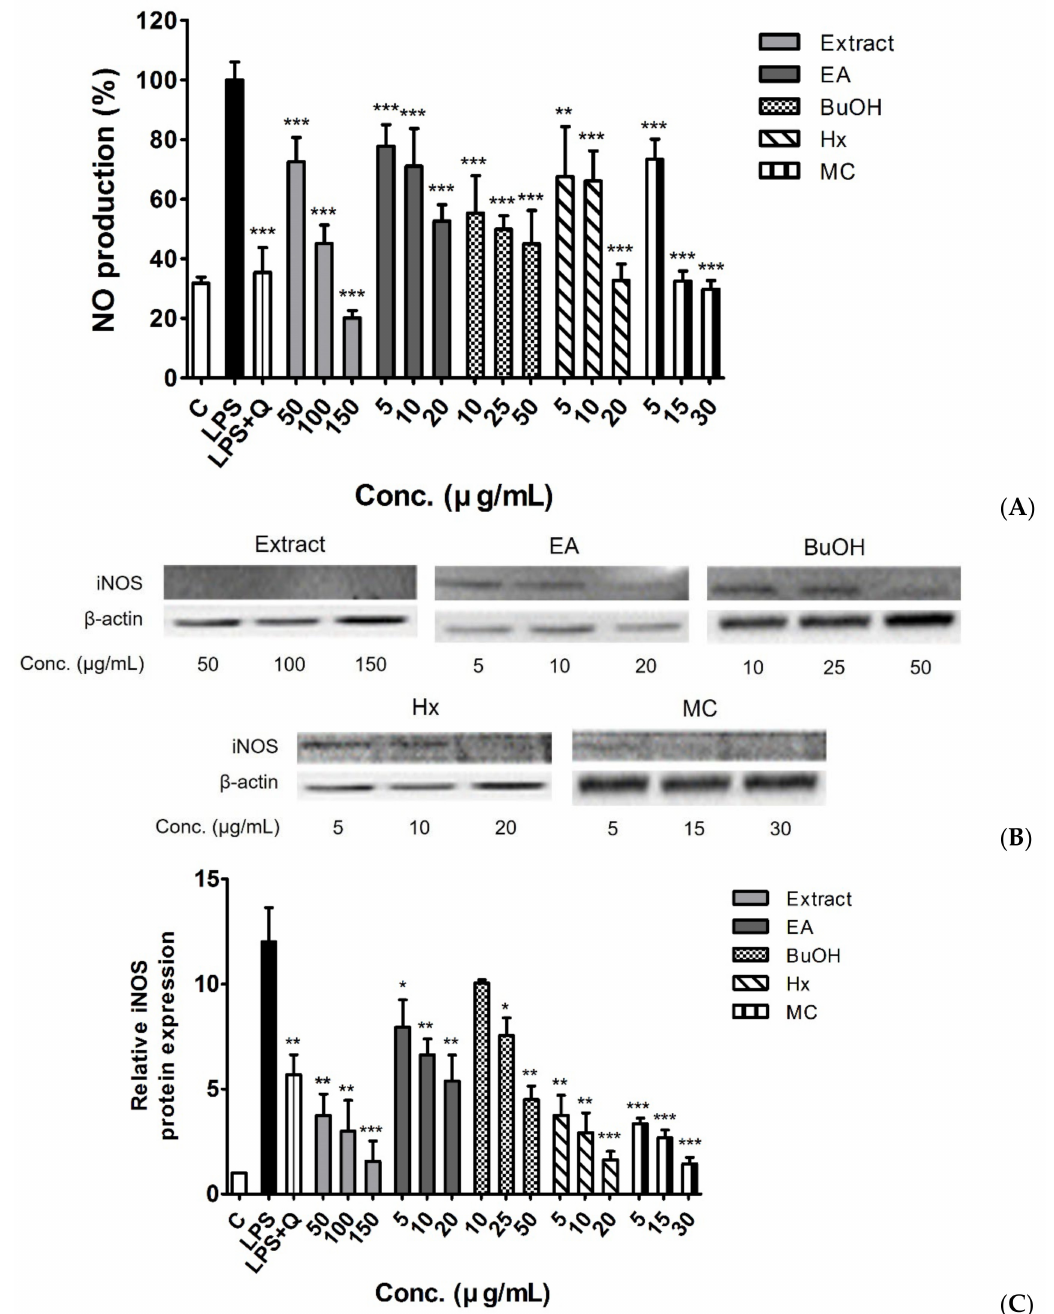
Figure 3. Effects of the EtOH extract and fractions of white mulberry fruits on NO production ( A ) and iNOS protein expression ( B , C ) in LPS-stimulated RAW 264.7 macrophages. Data are expressed as means ± SD ( n = 3). * p < 0.05, ** p < 0.01, and *** p < 0.001 vs. LPS